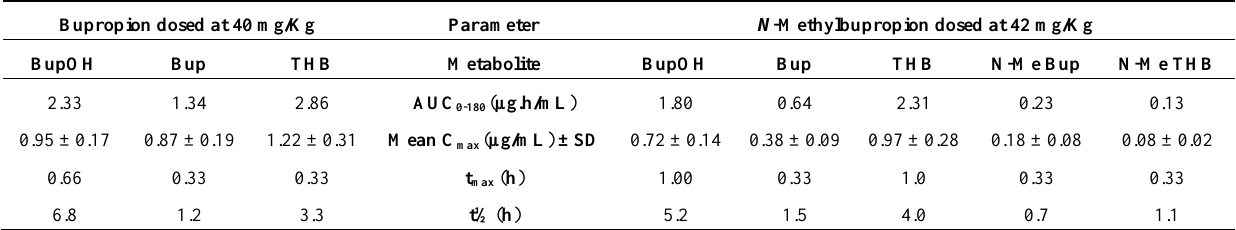
Table 1. The pharmacokinetic parameters for N -methylbupropion, bupropion and metabolites